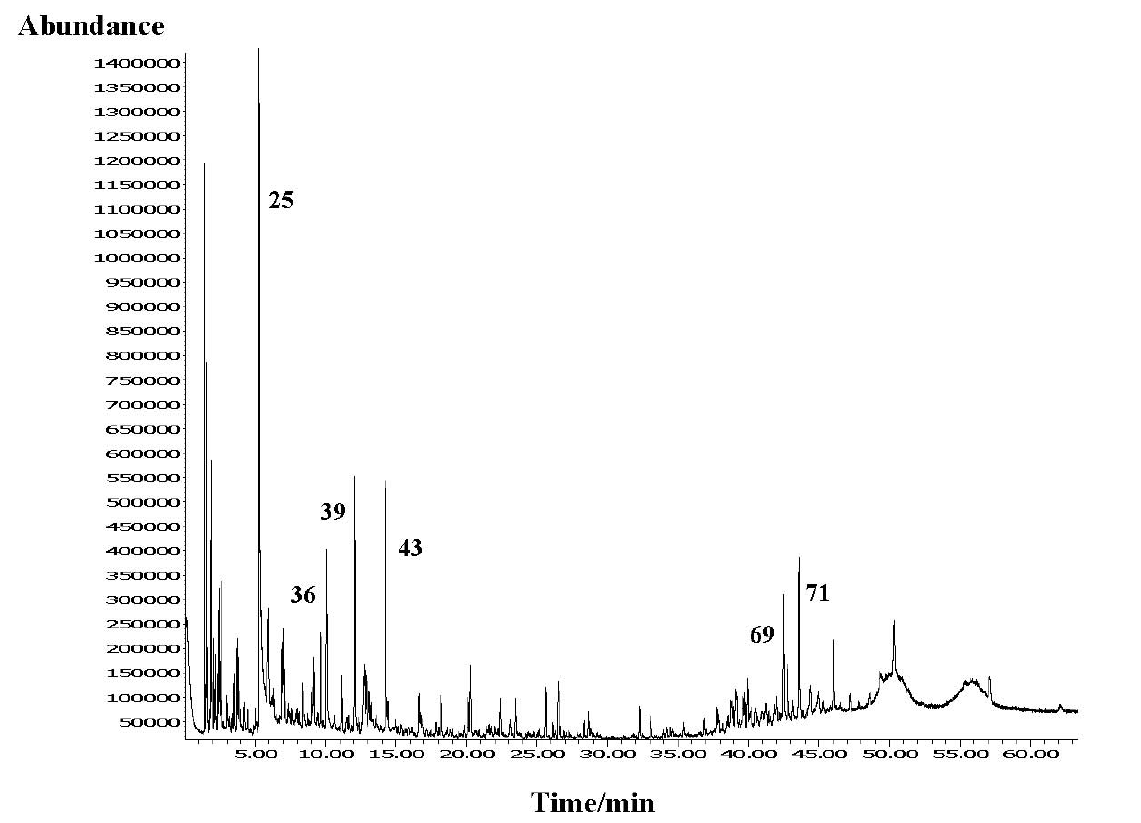
Figure 2. Total ion chromatogram of the organic residue headspace composition